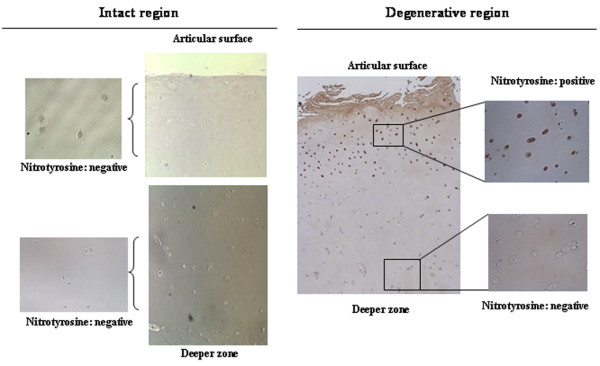
Representative immunohistochemical staining for nitrotyrosine in donor articular cartilage. Cartilage sections were immunostained using an anti-nitrotyrosine antibody. In donor-matched pairs of degenerative and intact regions from same cartilage explants (67-year-old donor), positive immunostaining for nitrotyrosine was observed in chondrocytes and in the cartilage matrix in degenerated regions, whereas the intact region from same cartilage sample showed no positive staining for nitrotyrosine. Original magnification: 40×.